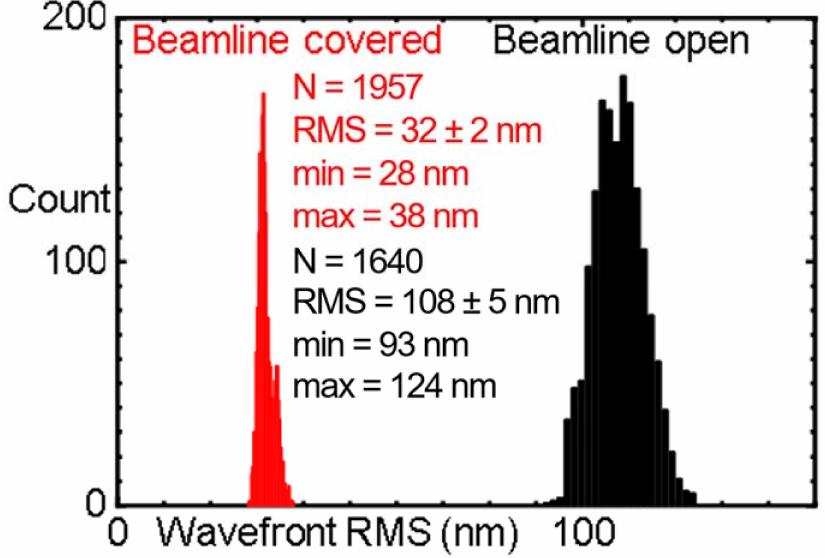
Figure 7. Effect of the beamline covering on the LD wavefront